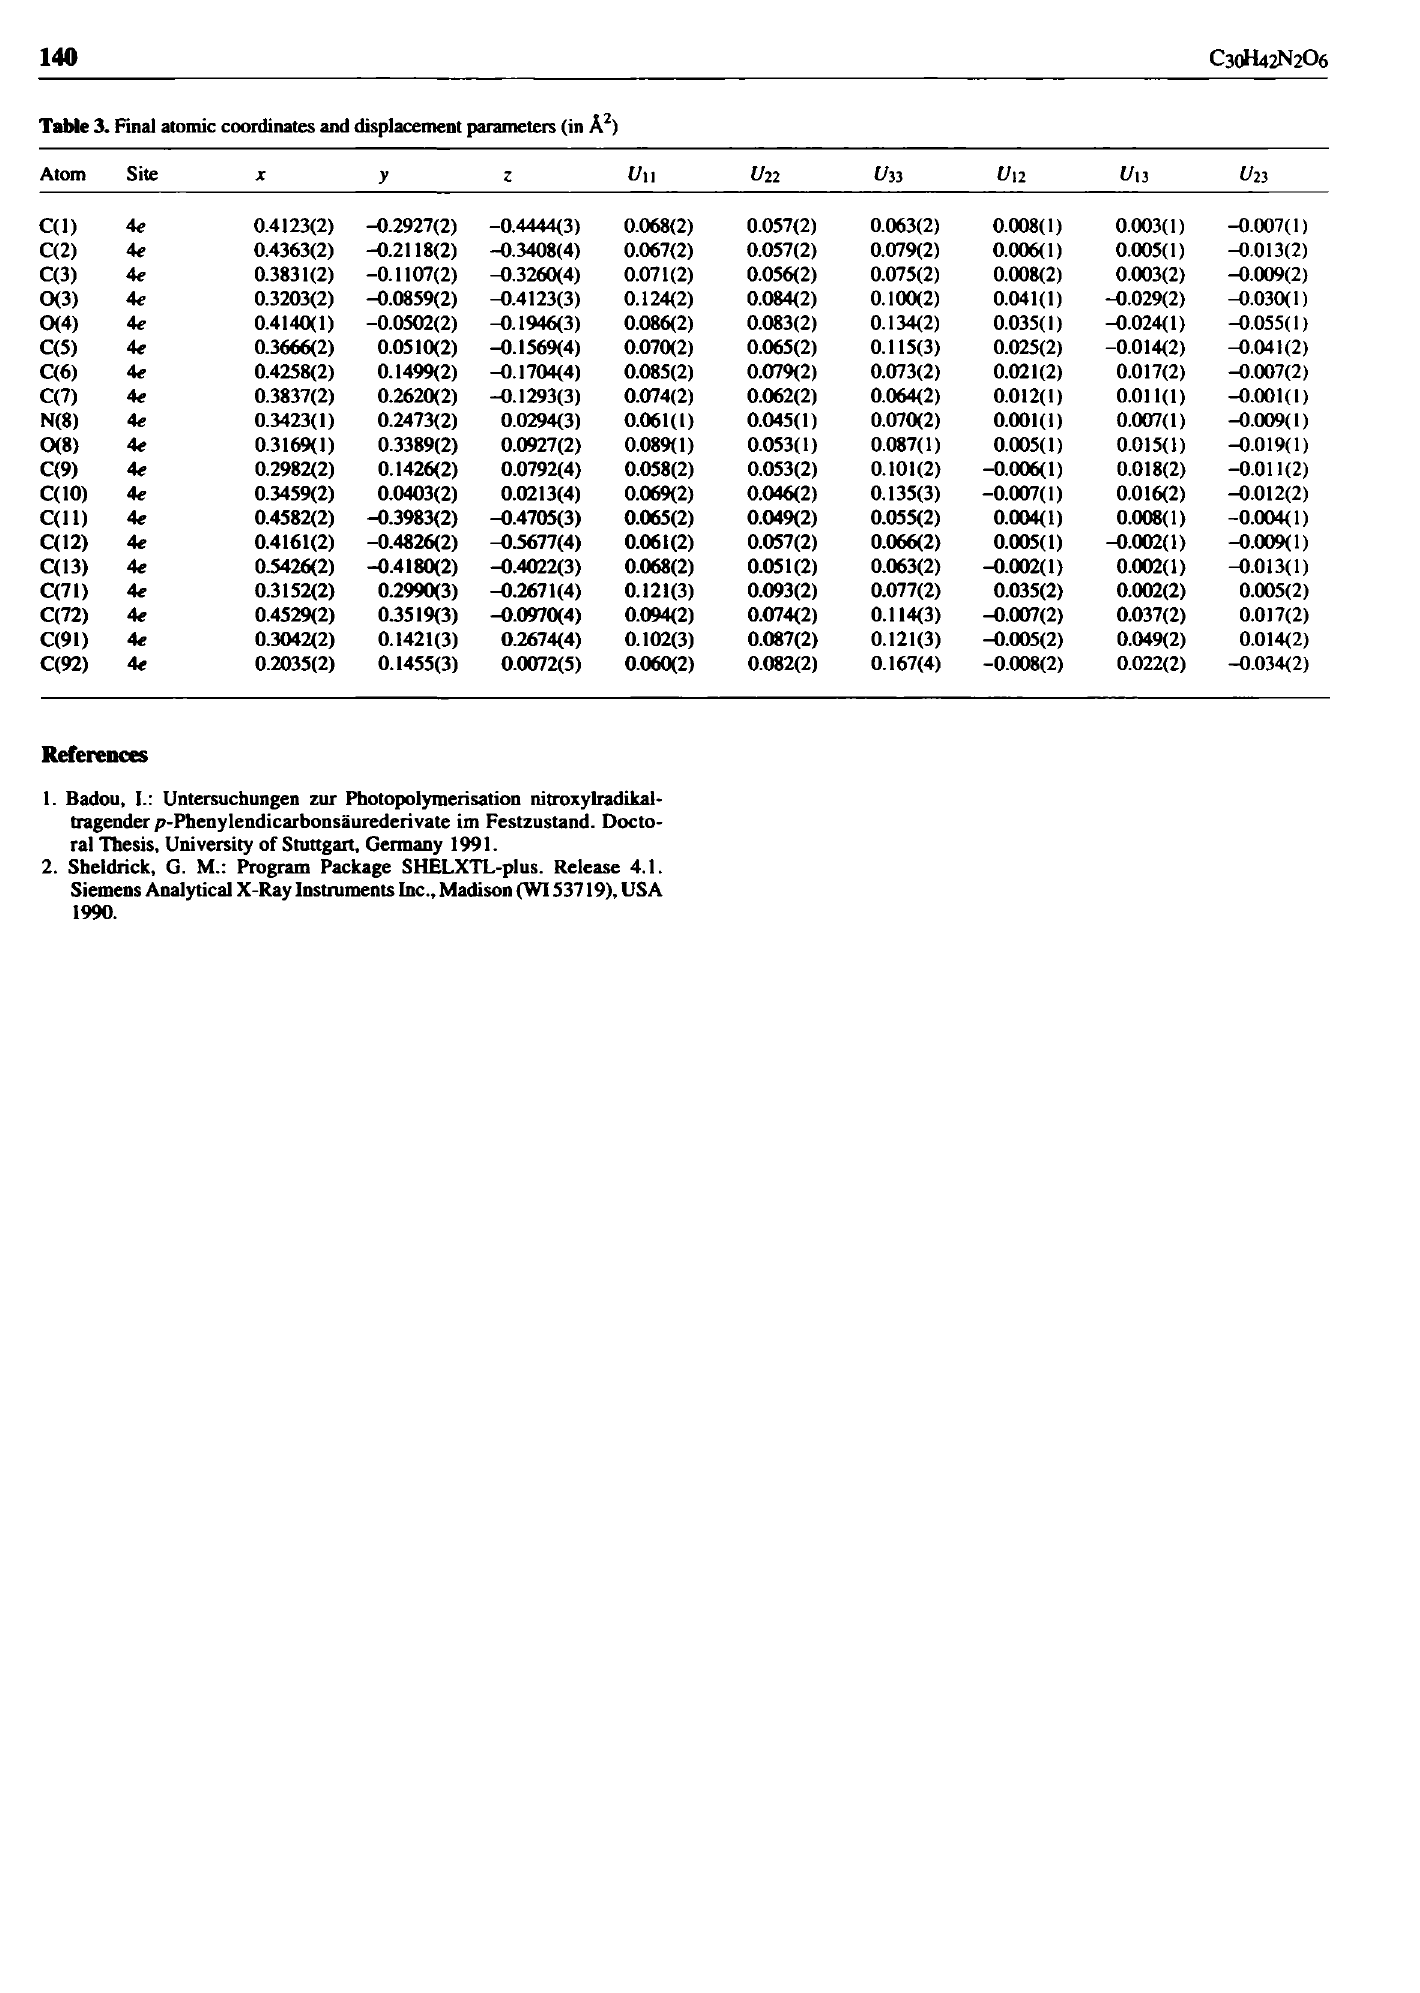
Table 3. Final atomic coordinates and displacement parameters (in À 2